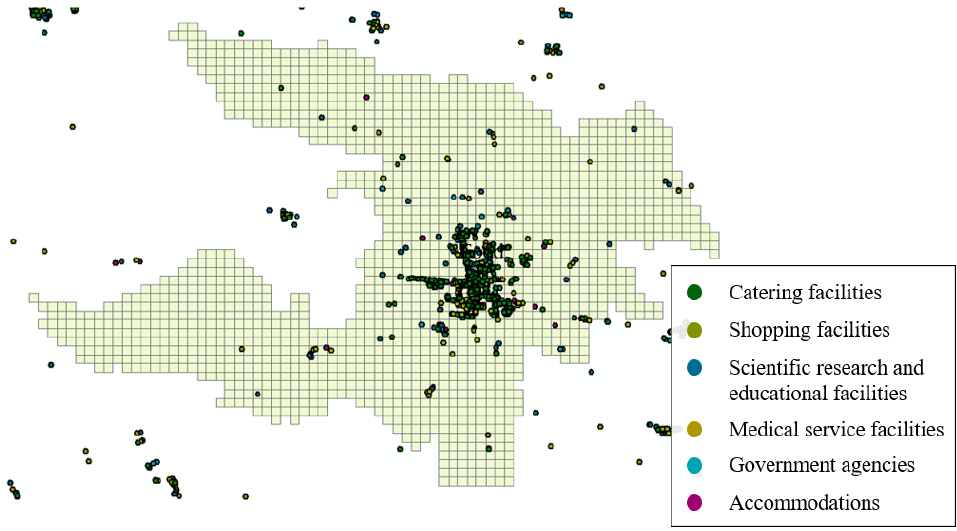
Figure 5. Distribution of related facilities.